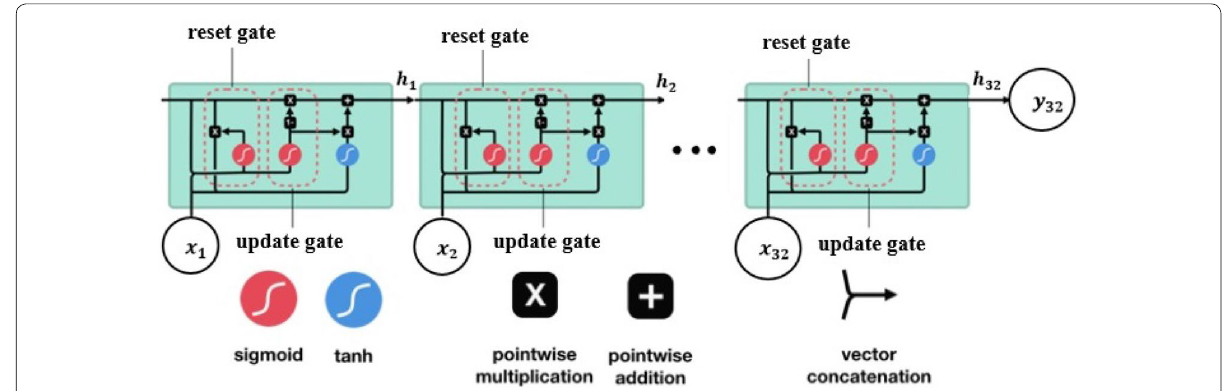
Fig. 6 Proposed GRU network for shopping behavior